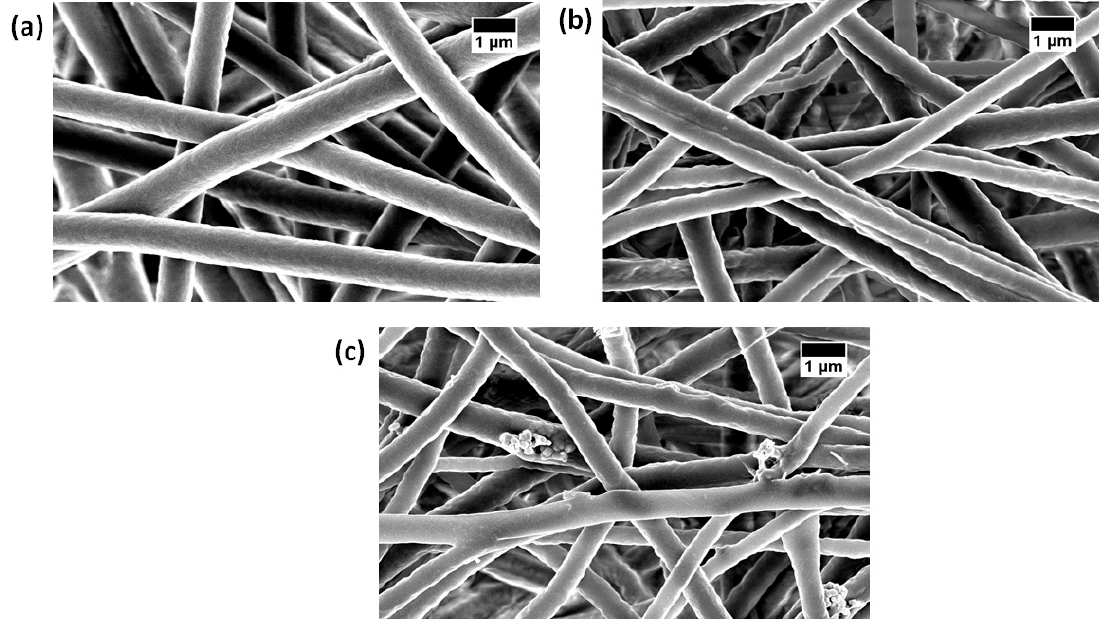
Figure 2. Field emission SEM (FESEM) images of ( a ) polyurethane (PU), ( b ) PU / BASIL and ( c ) PU / BASIL / TiO 2 .